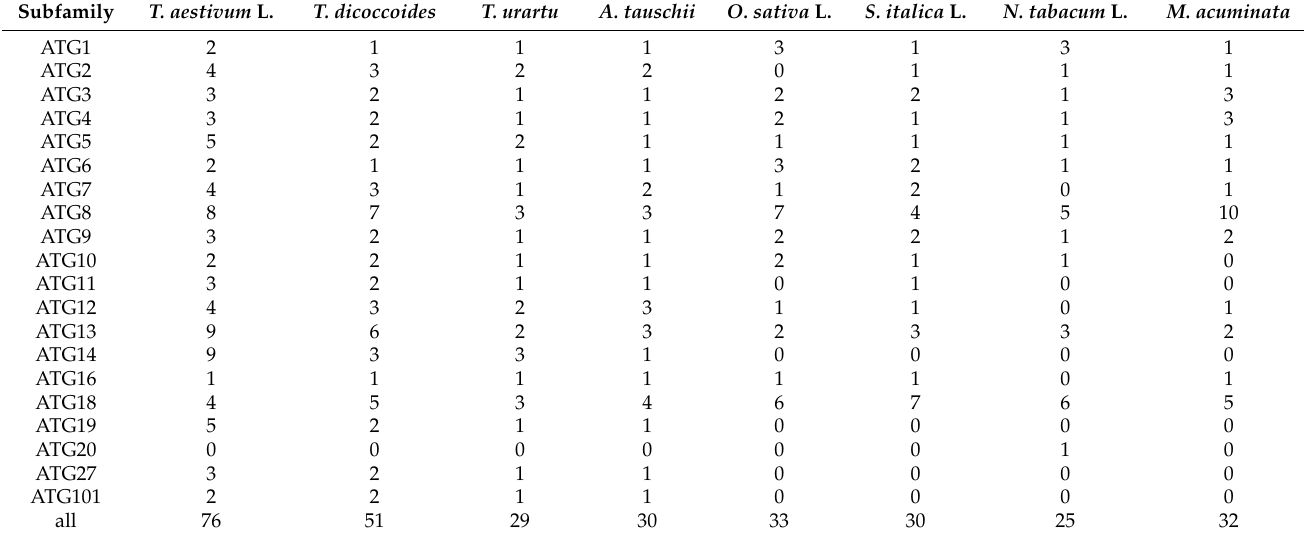
Table 1. The subfamily distribution of ATGs among different